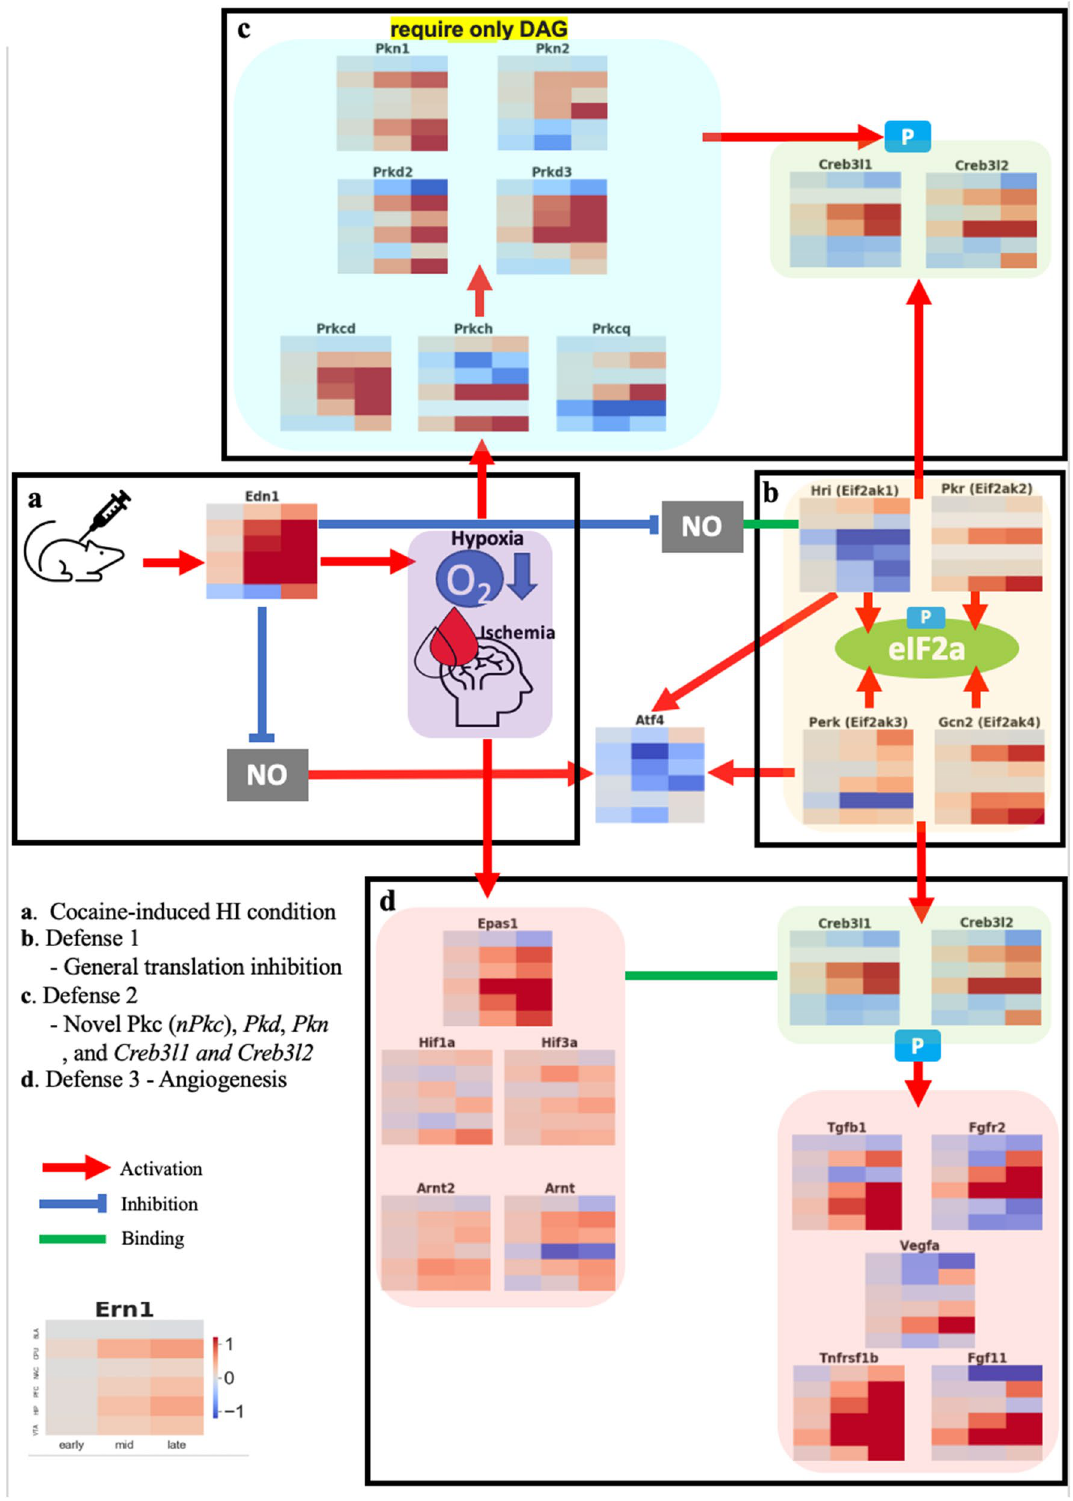
Figure 8. Overall defense mechanism in HI condition. ( a ) Cocaine causes upregulation of Edn1 which leads to inhibition of nitric oxide (NO) and hypoxia–ischemia (HI). ( b ) Phosphorylation of eIF2a caused by its kinases leads to inhibition of general translation ( c ) nPkc, Pkd and Pkn family function as not only defense system against HI but also phosphorylated Creb3l1 and Creb3l2 . ( d ) HIF interacts with Creb3l1 and Creb3l2 and they mediate